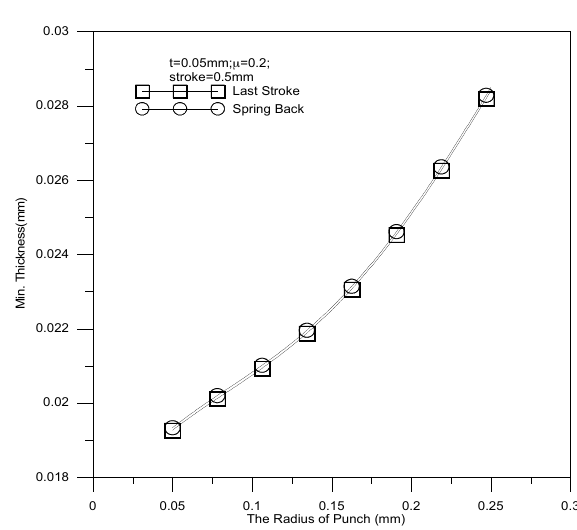
Figure 16. The relationship between sheet thickness and punch fillet radius.